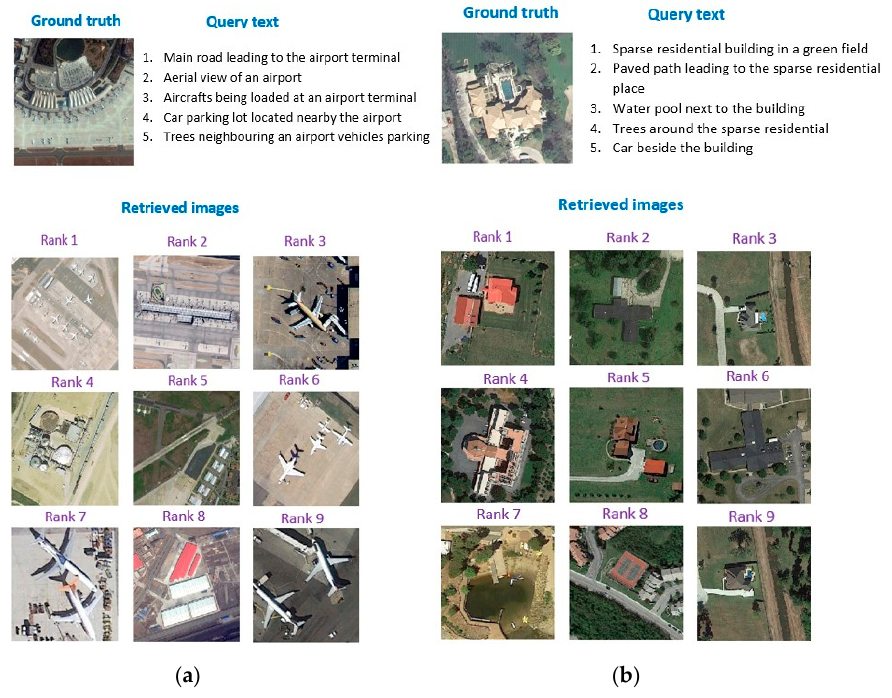
Figure 9. Successful scenarios (a, b and c) of text-to-image retrieval.